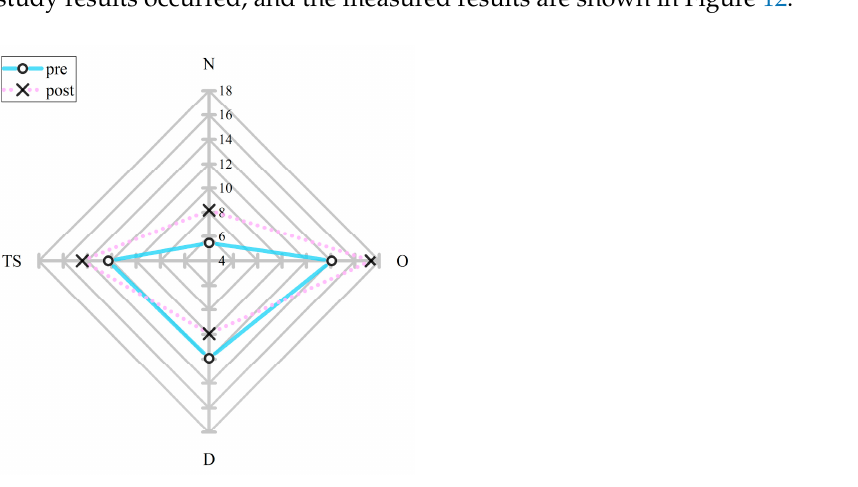
Figure 12. Average SSQ scores of subjects measured through pre- and post-questionnaires.